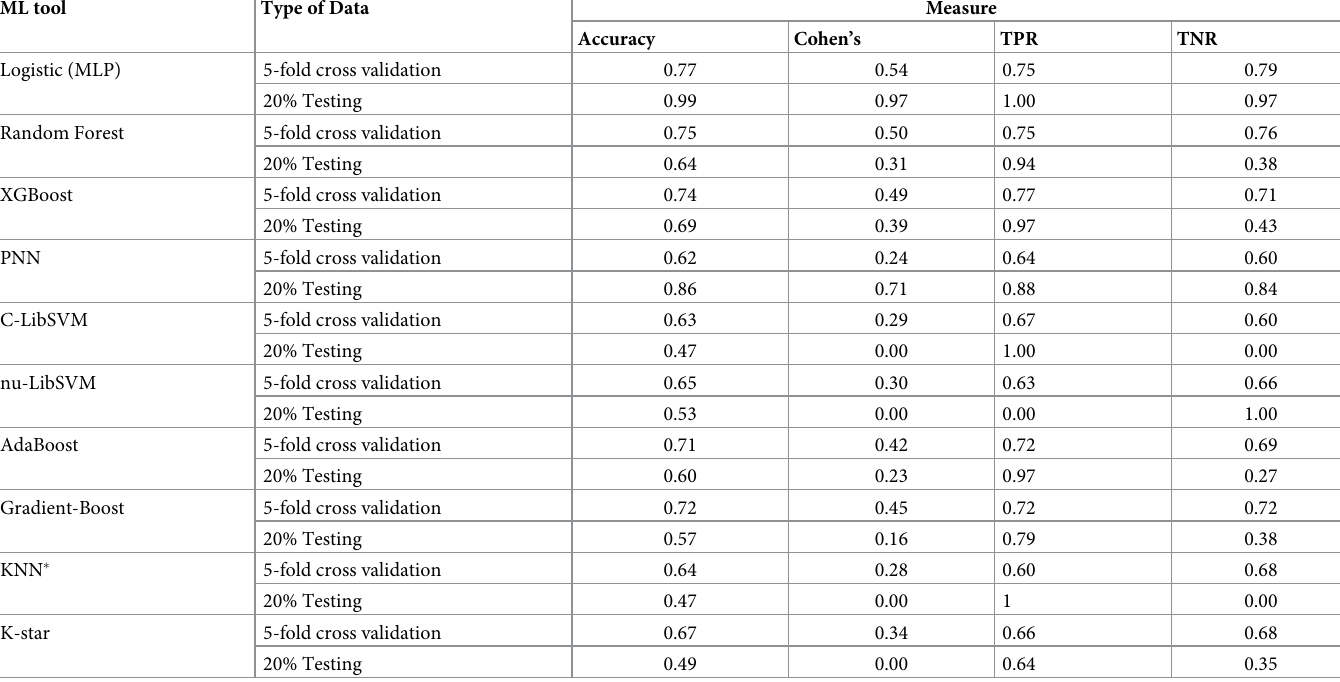
Table 10. Accuracy, cohen’s κ , TPR, and TNR values based for the all ML tools and using either 5-fold cross validation or 20% testing set for prediction people with T2DM from people without T2DM. ML tool